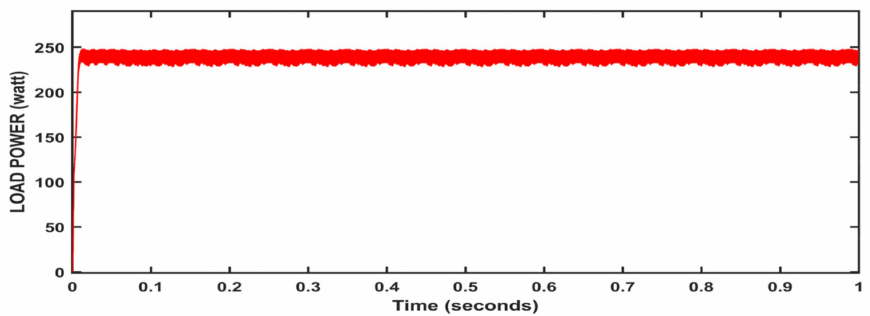
Figure 15. Algorithm performance under constant irradiation, load, and